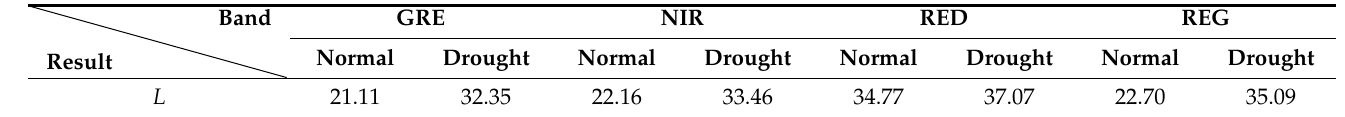
Table 9. Wilting index of the soybean canopy’s multispectral image in the V5 stage.